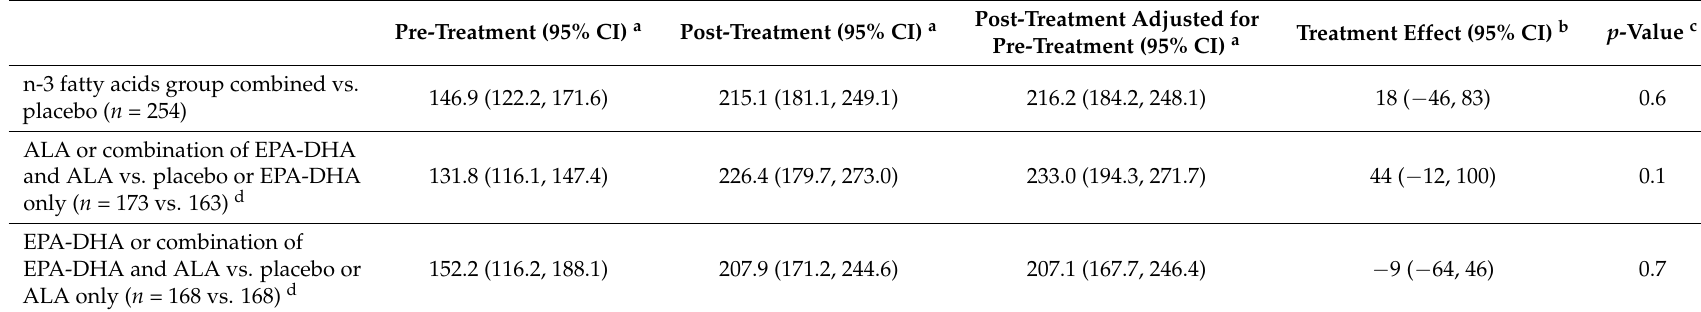
Table 3. Effect of 41 months intervention of omega-3 fatty acids on change in FGF23 levels in 366 patients of the Alpha Omega Trial with creatinine–cystatin